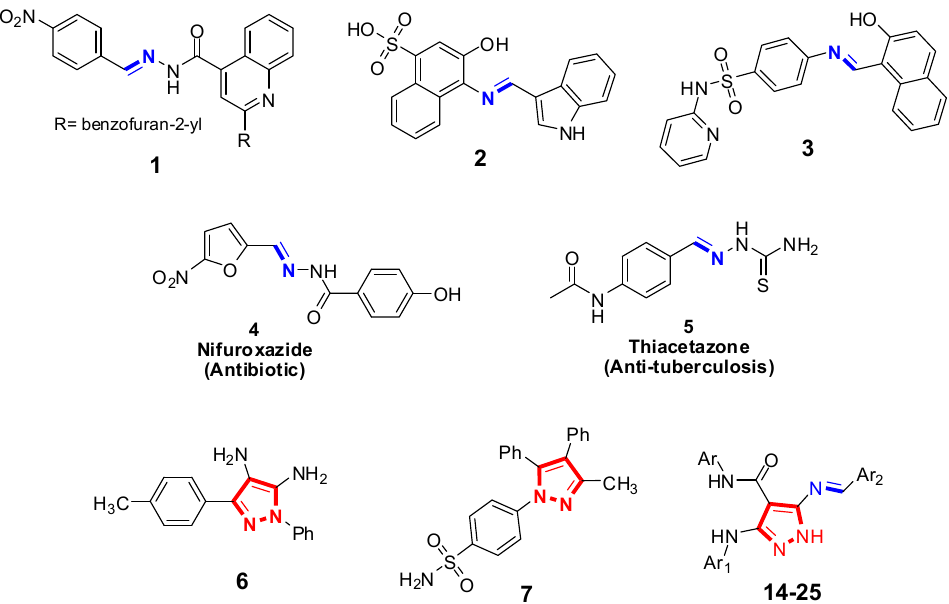
Figure 1. Structures of the antimicrobial Schiff bases 1 – 3 , Nifuroxazide 4 , Thiacetazone 5 , pyrazole derivatives 6, 7 and the target Schiff bases 14 – 25.